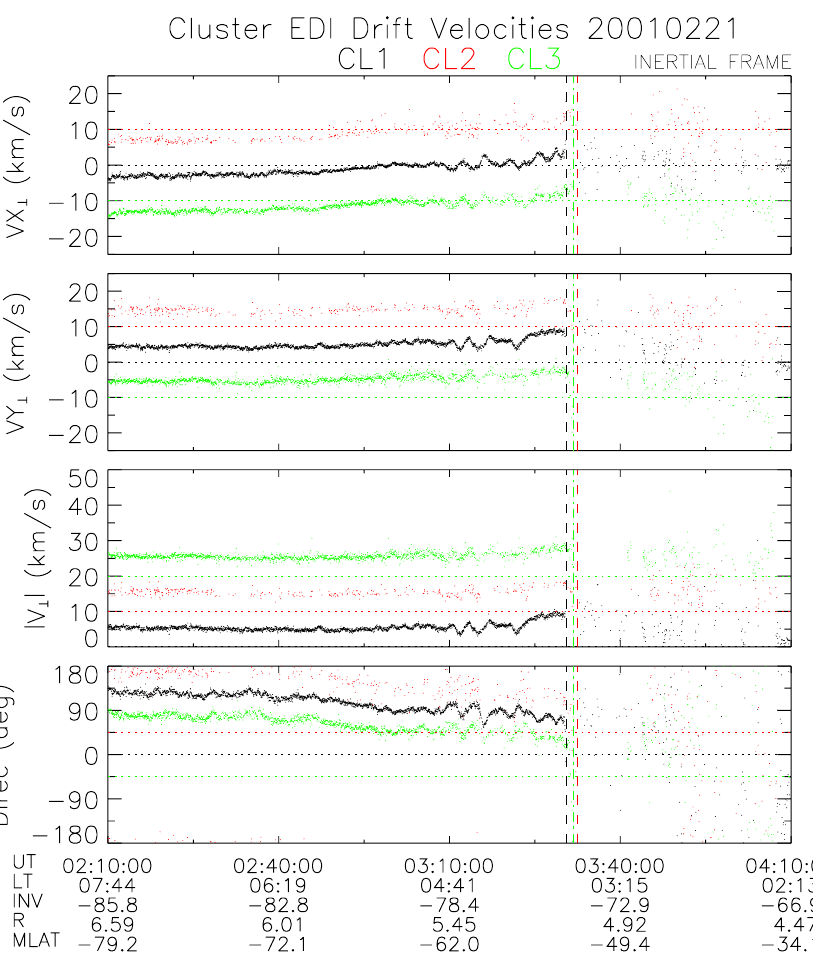
Fig. 9. Drift velocities during the 21 February southern hemisphere crossing from the polar cap into the high-latitude plasma sheet. Dashed markers plotted at the same times as those plotted in Fig. 8 and as the first set of markers in Fig. 11 indicate the satellites’ encounters with the first 1-keV electron